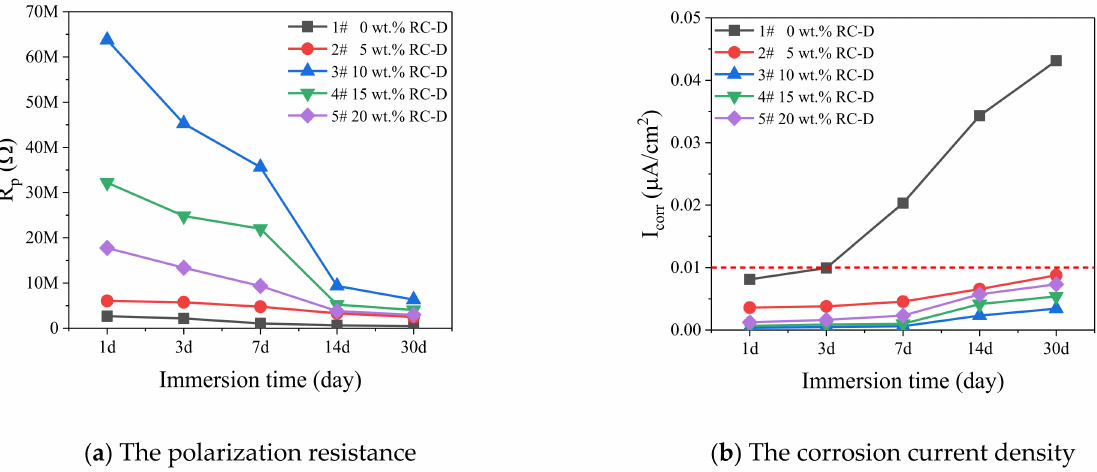
Figure 13. R p and I corr of different polymer-based coatings.